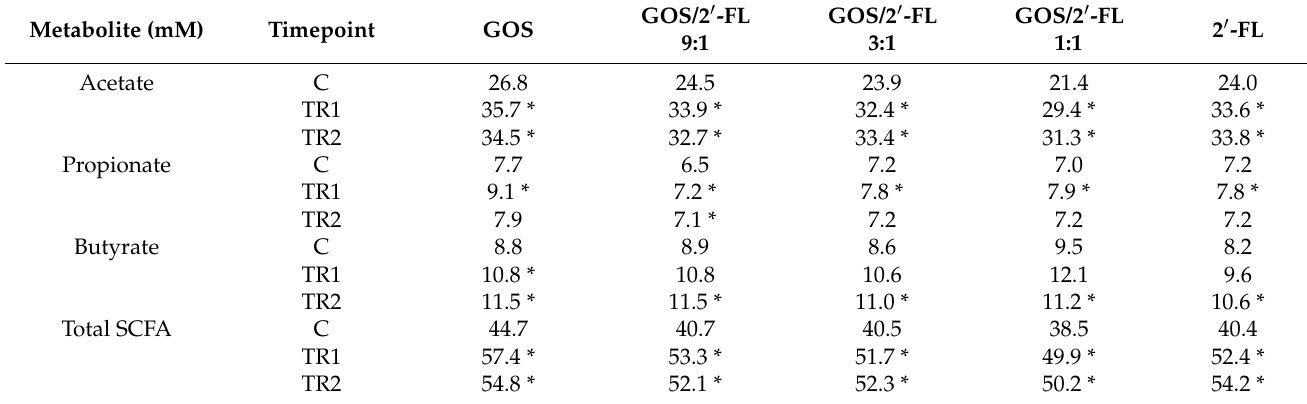
Table 1. Levels (mM) of acetate, propionate, butyrate, and total SCFA formed during the control (C) and treatment periods (first week, TR1; second week, TR2), with either 100% GOS or 100% 2 (cid:48) -FL, and different combinations of GOS and 2 (cid:48) -FL (depicted as 90/10, 75/25, 50/50 in percentages), in the simulated proximal colon of the baby M-SHIME ® . The average amounts calculated from three samples per week are presented and significantly different values ( t -test) are marked with an